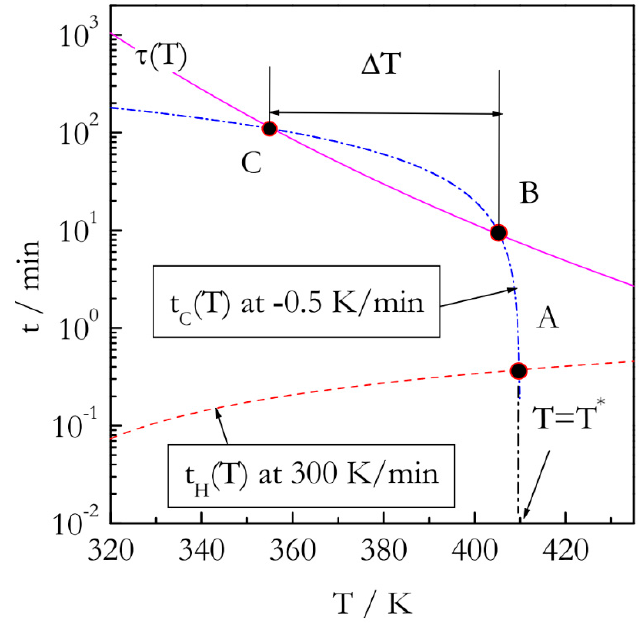
Figure 2. Temperature dependence of characteristic time, τ (T) (solid line) for a reaction with E = 60 kJ mol − 1 and A = 10 5 s − 1 . Turning temperature, T* = 410 K. Dash line: heating time, dash-dot line: cooling time. Time is on log scale.